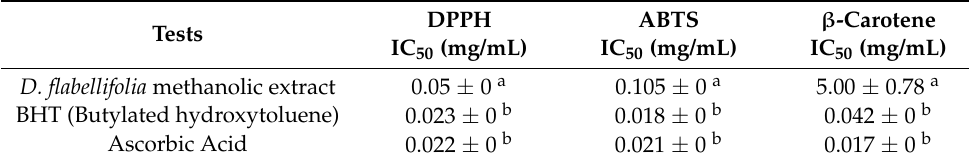
Table 4. Antioxidant activities of D. flabellifolia methanolic extract as compared to standard